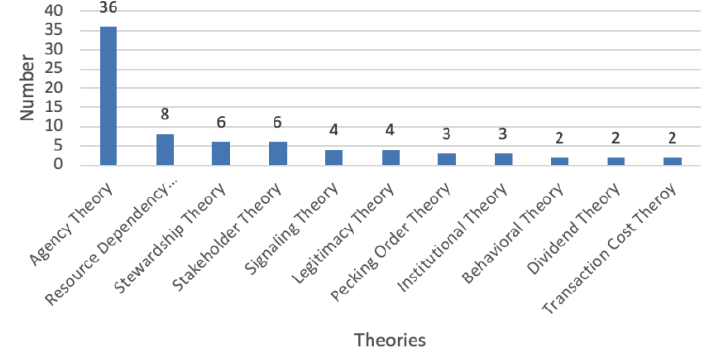
Figure 6: Theory